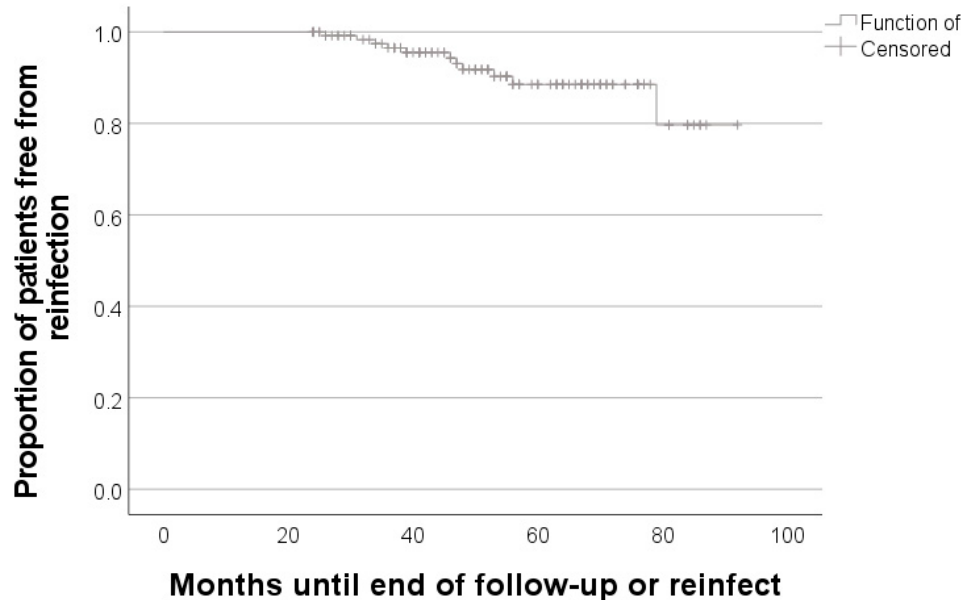
Figure 3. Kaplan–Meier curve for the proportion of patients free from